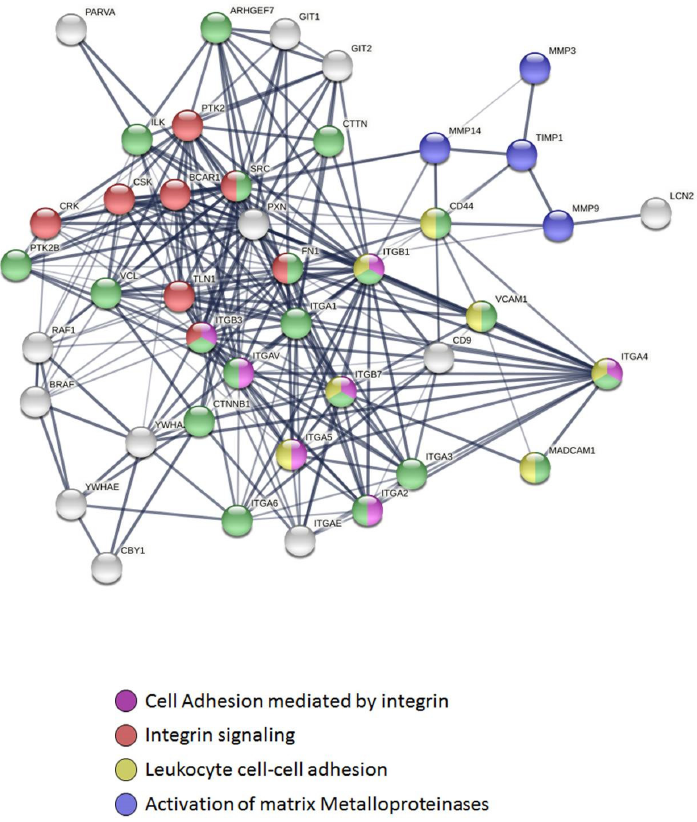
Figure 4. Effect of the Tn P peptide on the interaction with Homo sapiens ITA4 using the STRING database. Blockade of ITA4/VCAM-1 complex by Tn P generates compromise posterior signaling through MMPs, as well as TIMP-1 and adhesion molecules including other integrins and vinculin (VCL), PTK2B, and integrin-mediated signaling